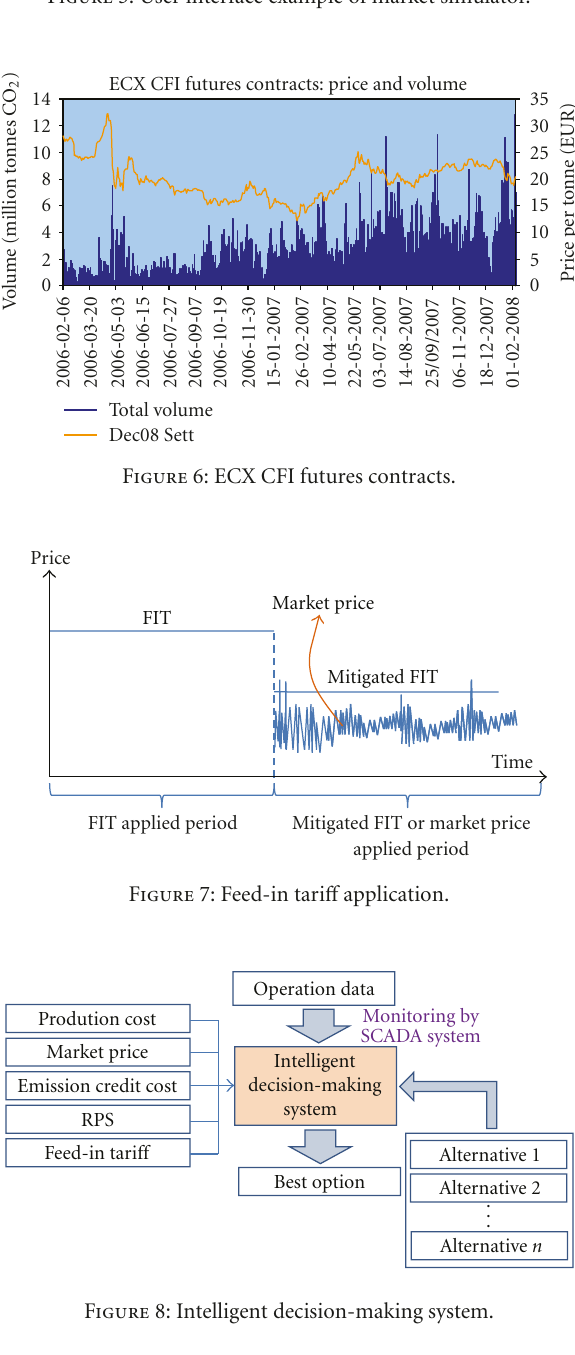
Figure 5: User interface example of market simulator.